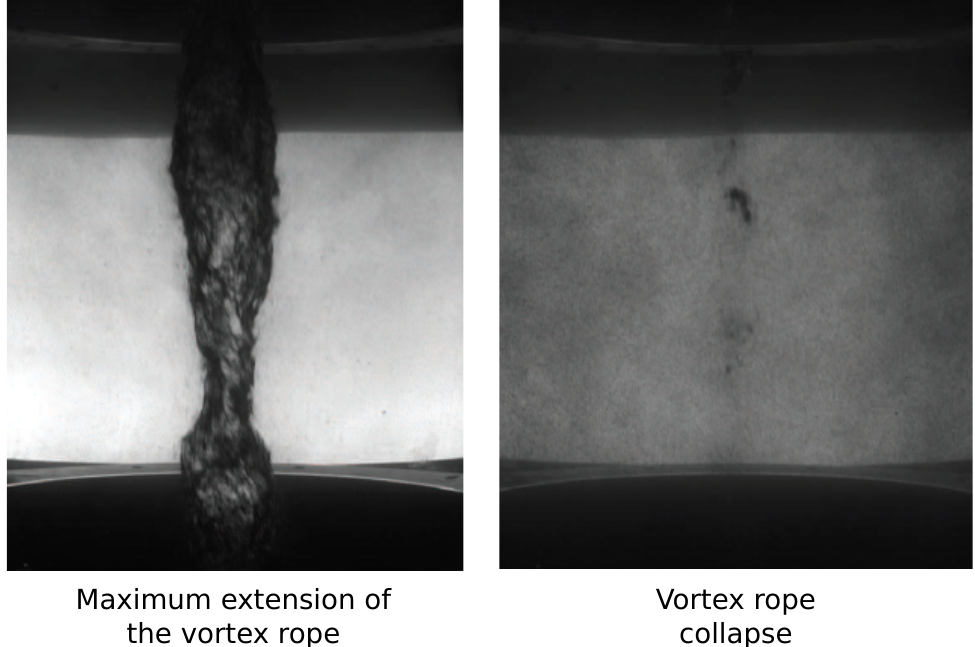
Figure 1. Experimental visualization of the vortex rope at full